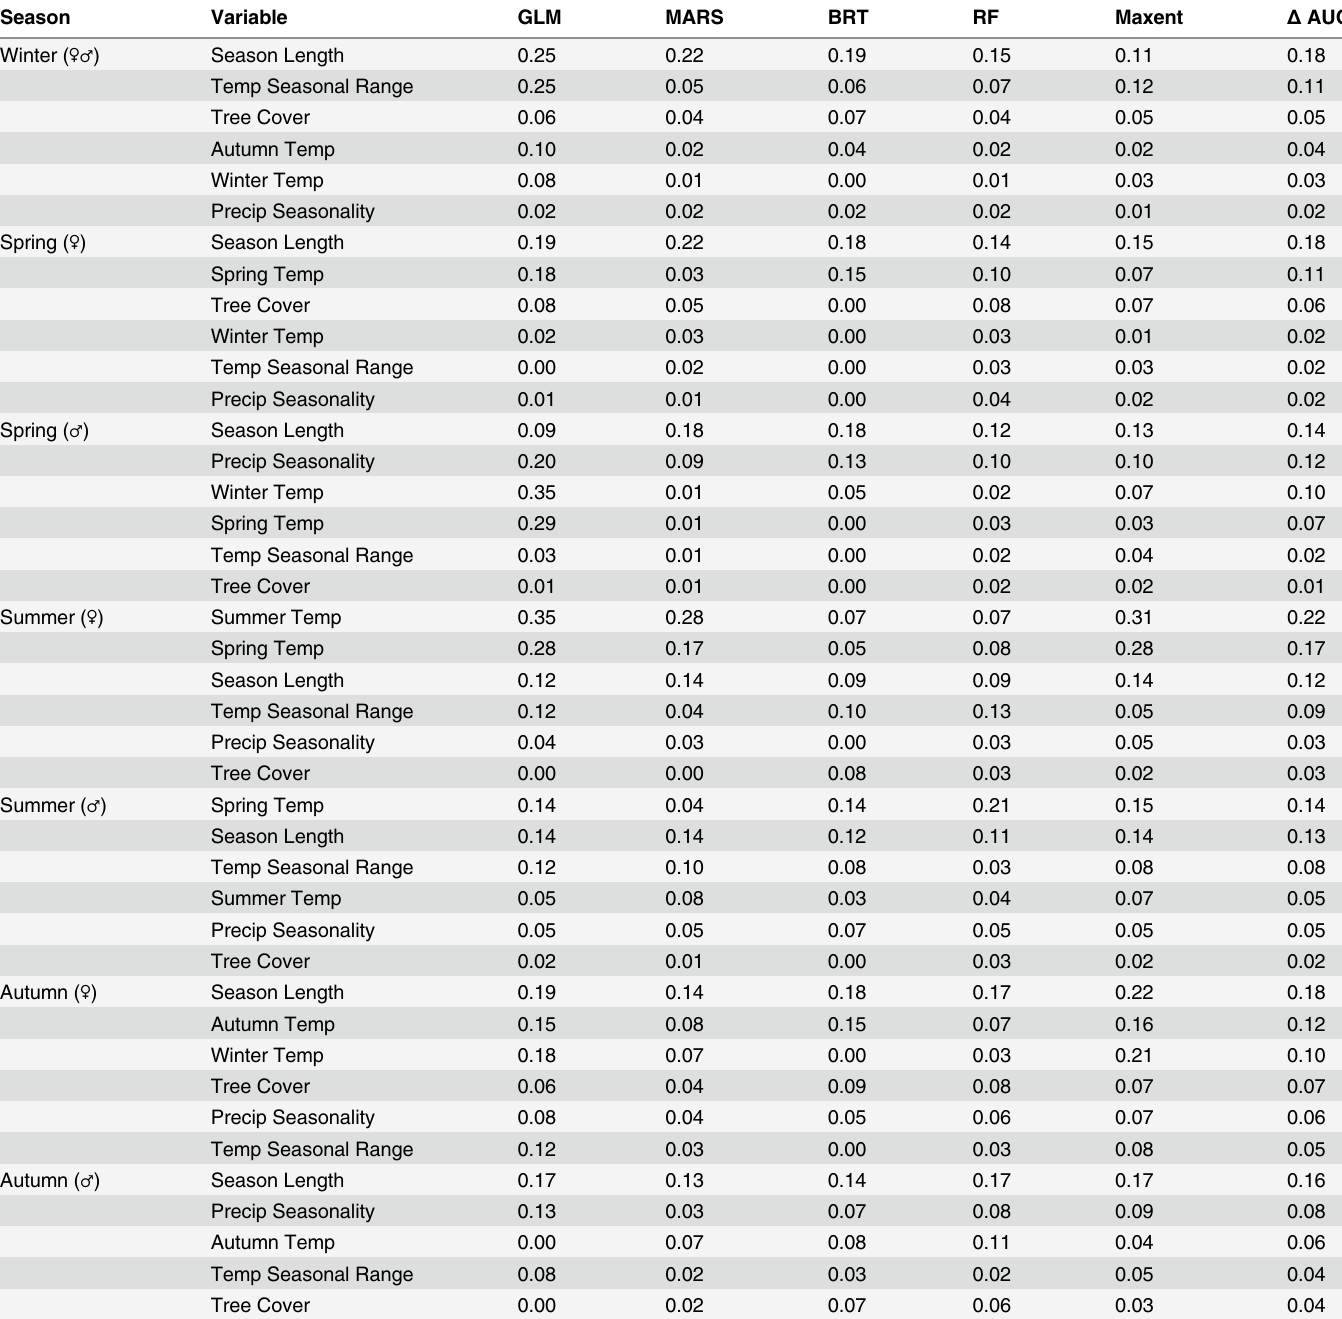
Table 4. Variable importance by season using increase in Area Under the Curve (AUC) when each predictor variable is permuted using 5 SDMs to model seasonal distributions of hoary bats ( Lasiurus cinereus ) in North America.